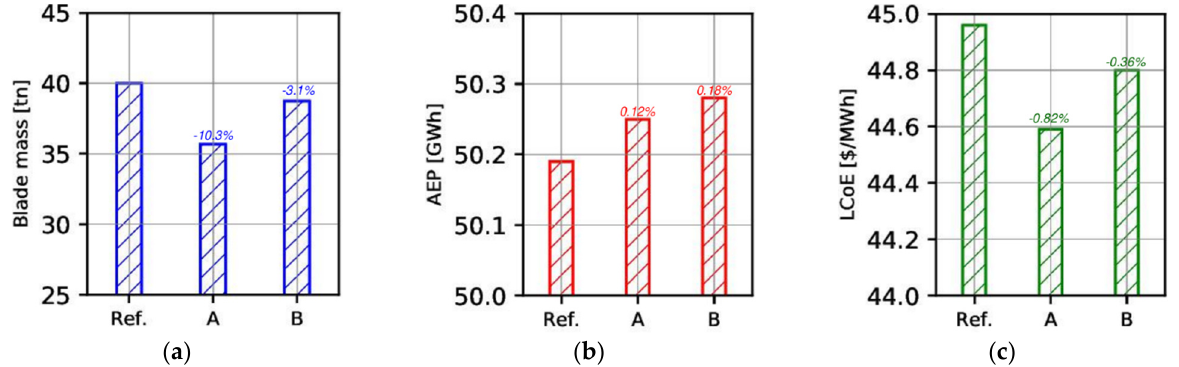
Figure 7. ( a ) Blade mass, ( b ) annual energy production and ( c ) Levelized Cost of Energy, of the material FEC (CASE A) and the geometric FEC (CASE B) designs and relative percentage differences with respect to the reference configuration.